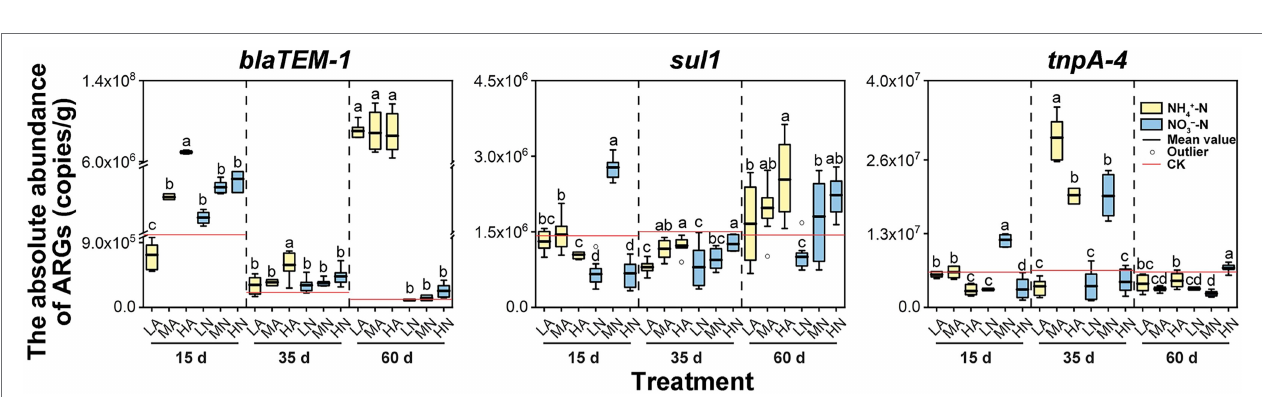
FIGURE 1 | The absolute abundance of ARGs in the soil, roots, and leaves at three growth periods (15, 35, and 60 days) with no nitrogen application (CK). Error bars represent standard deviations of triplicate samples. Different lowercase letters above the bars indicated significant differences among growth periods at p < 0.05.